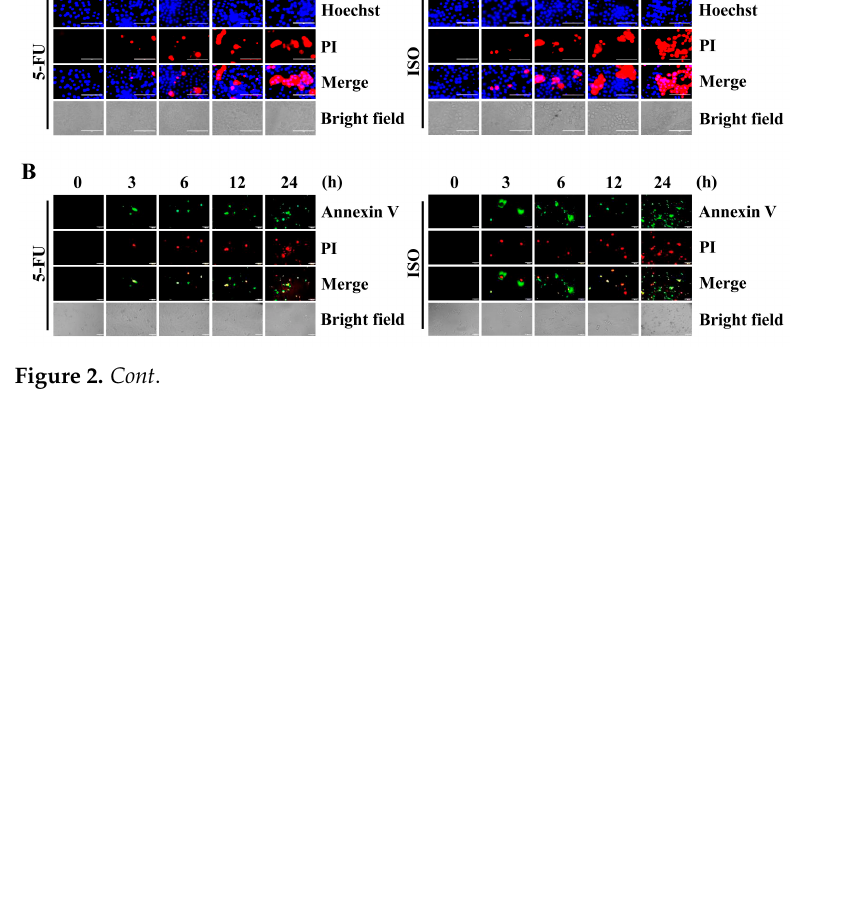
Figure 2. Apoptotic effects of ISO in AGS cells. A total of 36.54 µM ISO was applied to AGS cells from 0 to 24 h. ( A ) AGS cells after Hoechst and PI staining were observed by fluorescence microscope (original magnification, × 200). ( B ) AGS cells after Annexin V and PI staining were observed by fluorescence microscope (original magnification, × 400). ( C ) Apoptosis rate of AGS cells. ( D ) Flow cytometry was used to calculate the mitochondrial membrane potential. ( E ) Expression levels of apoptosis – related proteins in AGS cells treated with ISO. The α – tubulin was used as an internal reference protein. * p < 0.05, ** p < 0.01 and *** p < 0.001 vs. 0 h. 2.3. Isoorientin Regulates MAPK/STAT3/NF– κ B Signaling Pathways As seen in Figure 3A, ISO considerably decreased the expression levels of p – ERK, p – STAT3, and NF – κ B while significantly upregulating the expression levels of p – JNK, p – p38, and I κ B α in a time-dependent way. Then, we tested several nuclear proteins and found that ISO significantly reduced the levels of STAT3, NF – κ B, and p – I κ B α (Figure 3B). As seen in Figure 3C – E, compared with the ISO alone treatment groups, FR180204, SP600125, and SB203580 inhibited the expression of p – ERK, p – JNK, and p – p38 in AGS cells, respectively. Meanwhile, pretreatment with ERK inhibitors enhanced the decrease in p – STAT3 and Bcl – 2 protein expression levels and inhibited the increase in cle – caspase – 3 protein expression, while the level of p – STAT3 after pretreatment with the JNK inhibitor or p38 inhibitor was higher than that of ISO treatment alone. The above results indicate that the MAPK – dominated ISO – induced AGS cell apoptosis is an upstream signaling pathway.